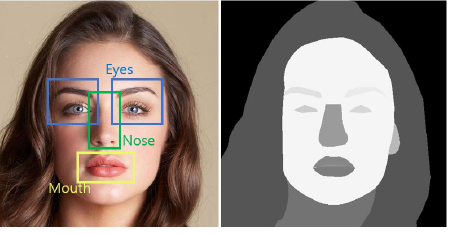
Figure 6. Original HR-FI ( left ) and its parsed HR-FI ( right ).